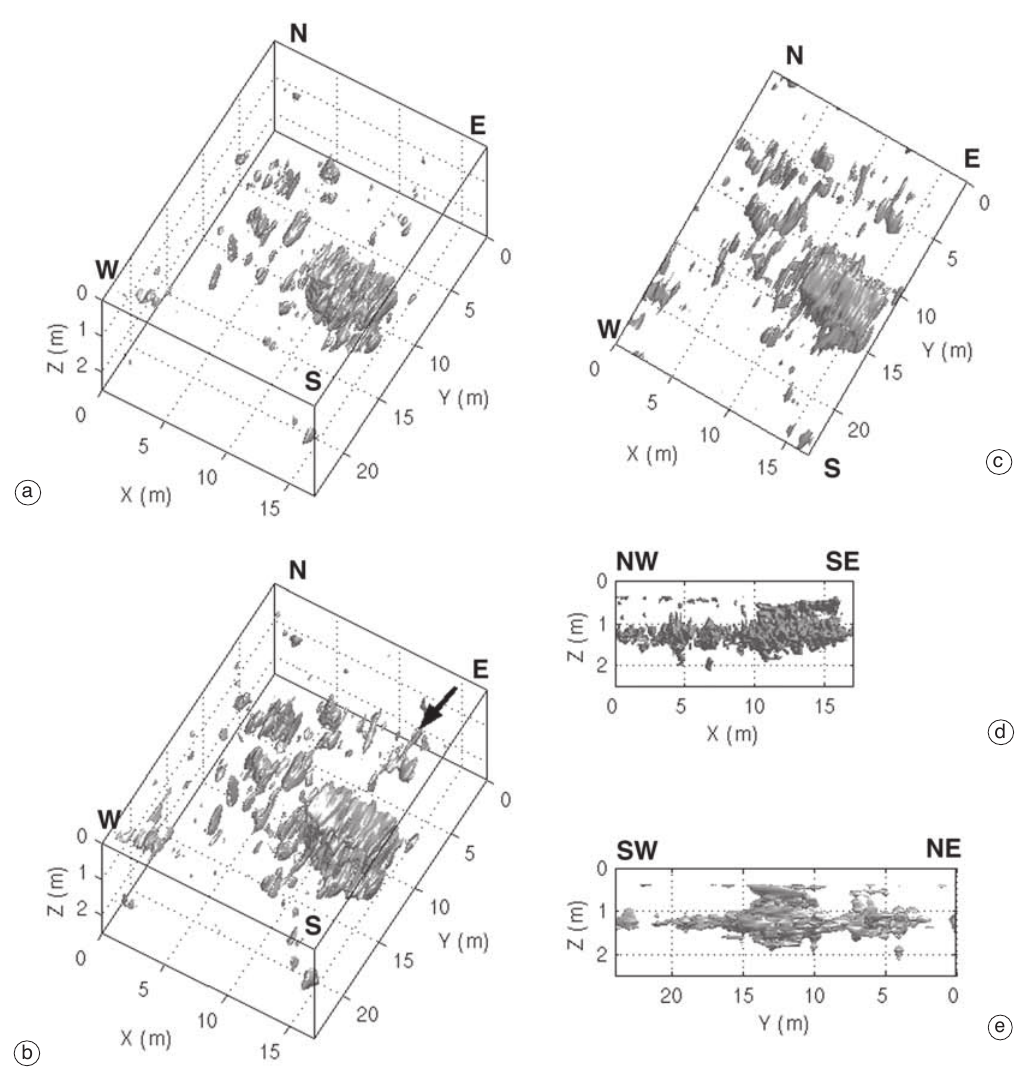
Fig. 6a-e. Zone D. 3D visualization by means of iso-amplitude surfaces of the complex trace amplitude. Perspective views (from the south) using different thresholds: 50% (a) and 40% of the maximum (b), and different views using the same threshold (40%): plan (c), front (d) and lateral view (e); the arrow denotes a linear anomaly probably due to a ditch in the